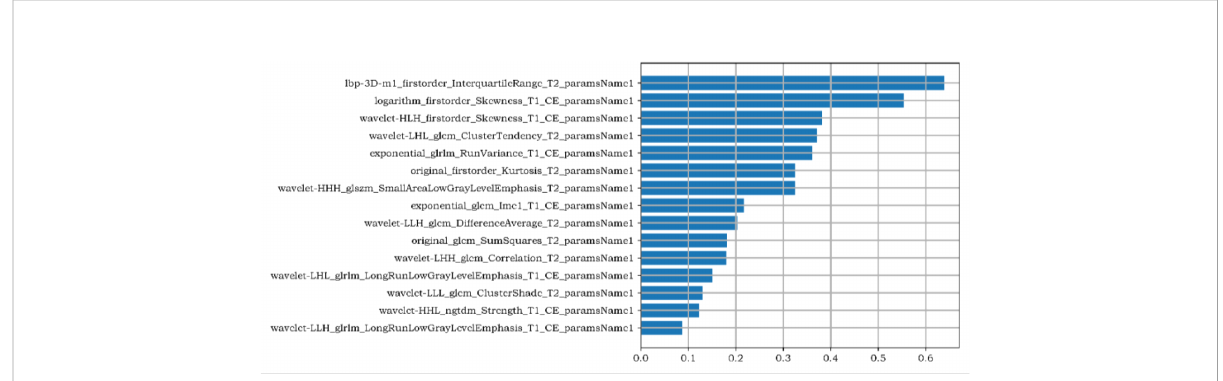
FIGURE 2 The Gini Coef fi cient importance analysis of radiomics features. The three radiomics features with the highest contribution are the inter quartile range of the fi rst-order feature, the skewness of the fi rst-order feature after logarithm, and the skewness of the fi rst-order feature fi ltered by high-low- high wavelet fi lters in XYZ direction,.